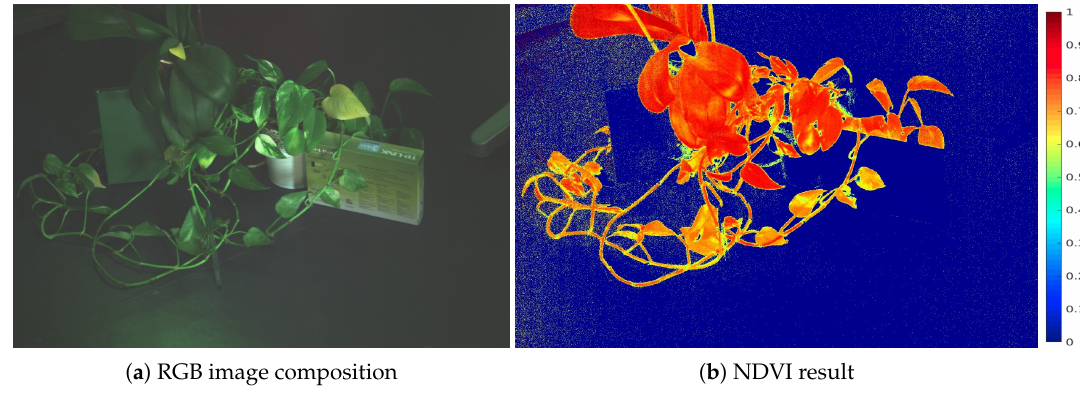
Figure 12. Images captured in the laboratory with the multispectral camera.